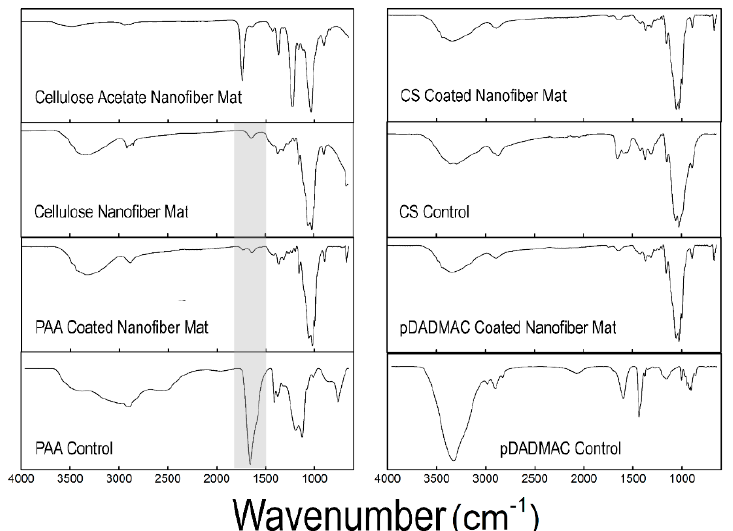
Figure 2. FTIR spectra of the as-spun cellulose acetate nanofiber mat and the regenerated cellulose nanofiber mat are displayed, along with the spectra for cellulose nanofiber mats functionalized with PAA, CS, and pDADMAC. Control spectra for PAA, CS, and pDADMAC are also provided. The highlighted region shows the addition of a peak in the 1700 cm − 1 region that correlates with C=O of carboxylic acid for the PAA-functionalized cellulose nanofiber mats. FTIR spectra was acquired on N = 3 samples. Table 1. Summary of the materials properties of polyelectrolyte-functionalized electrospun cellulose nanofiber